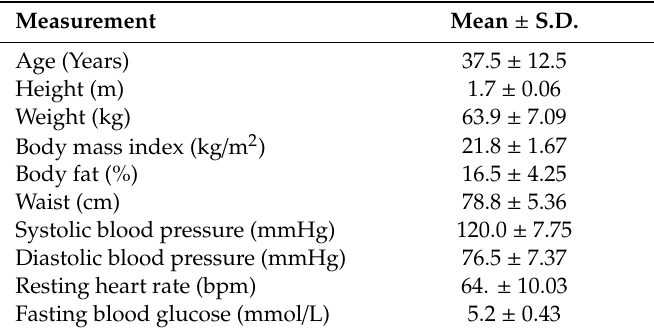
Table 2. Baseline anthropometric and metabolic